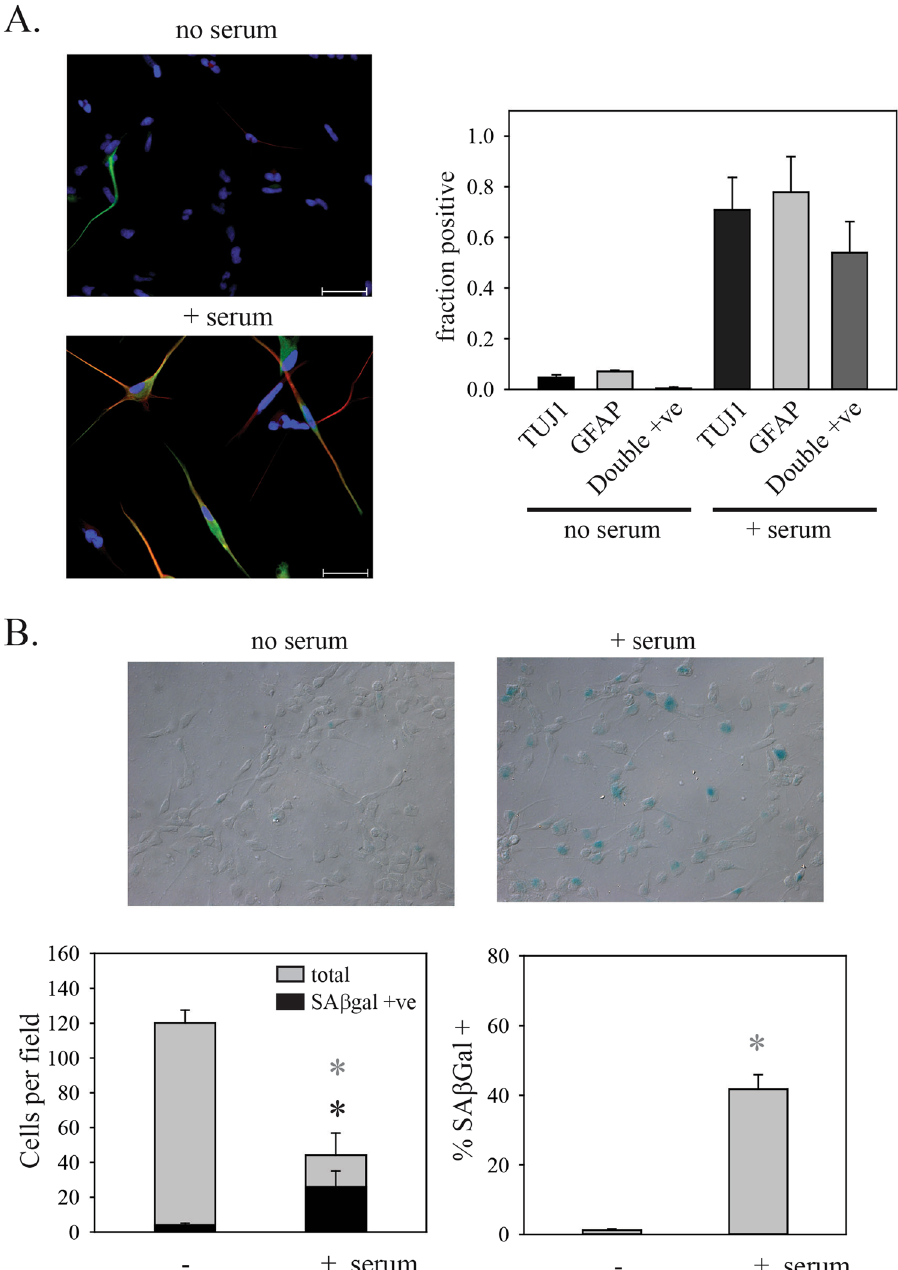
Figure 1. Serum induces aberrant differentiation and senescence. ( A ) PriGO8A cells were untreated or treated with 5% serum for seven days. Cells were then fixed and double immunofluorescence for GFAP (green) and TUJ1 (red) was performed. Nuclei were stained with DAPI (blue). Left panels show representative examples of immunofluorescence. The right panel show quantitation of the numbers of positive cells. ( B ) PriGO8A cells were untreated or treated with 10% serum for seven days. Cells were then fixed and stained for SA β gal activity. The upper panels show representative images of cells stained for SA β gal after treatment without or with serum. Images were taken using differential interference contrast microscopy. The right graph shows total cells (light grey bars) and SA β gal-positive cells per field. The left graph shows the same data plotted to show the change in the percentage of SA β gal-positive cells. For ( A and B ), data are from analysis of five random fields per condition. Error bars show the standard error. In ( B ), statistical significance was determined using the Mann- Whitney Rank Sum test. * Indicates p <